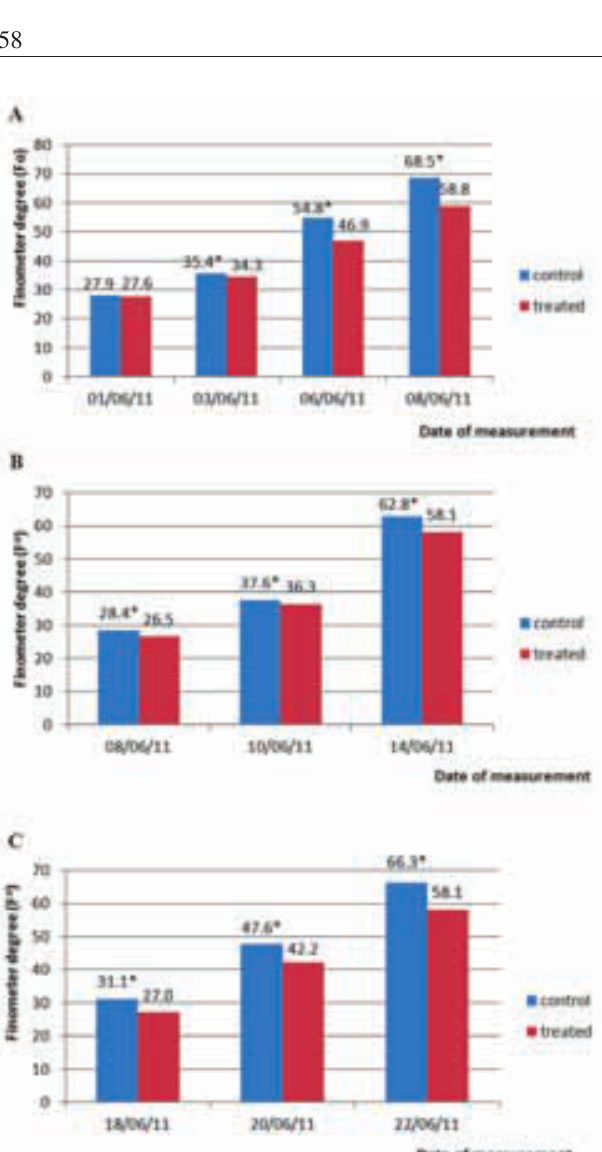
Figure 1. Changes of the tenderness of different green pea varieties in 2011. A: ‘Léda’ B: ‘Zita’ C: ‘Zsuzsi’. * signifi cant differences (P<0.05); e: excellent, I.: First class, II.: Second class, n: outside of class (not suitable for the canning industry)